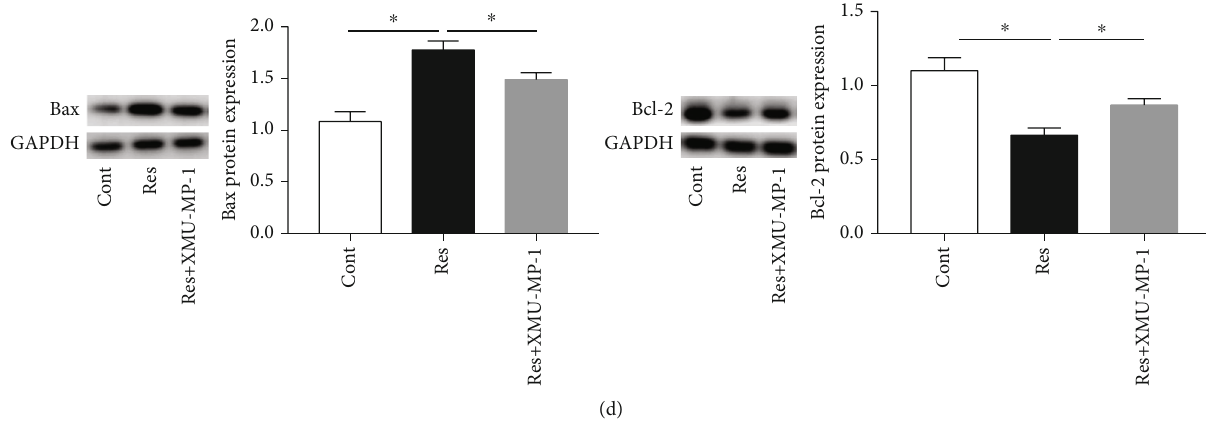
Figure 7: Loss of Hippo pathway activation attenuates the Res-induced inactivation of HSCs. (a) YAP expression. (b) α -SMA expression. (c) Col1A1 and type I collagen expression. (d) Bax and Bcl-2 expression. Values are expressed as means ± SD . ∗ P < 0 : 05 and ∗∗ P < 0 : 01